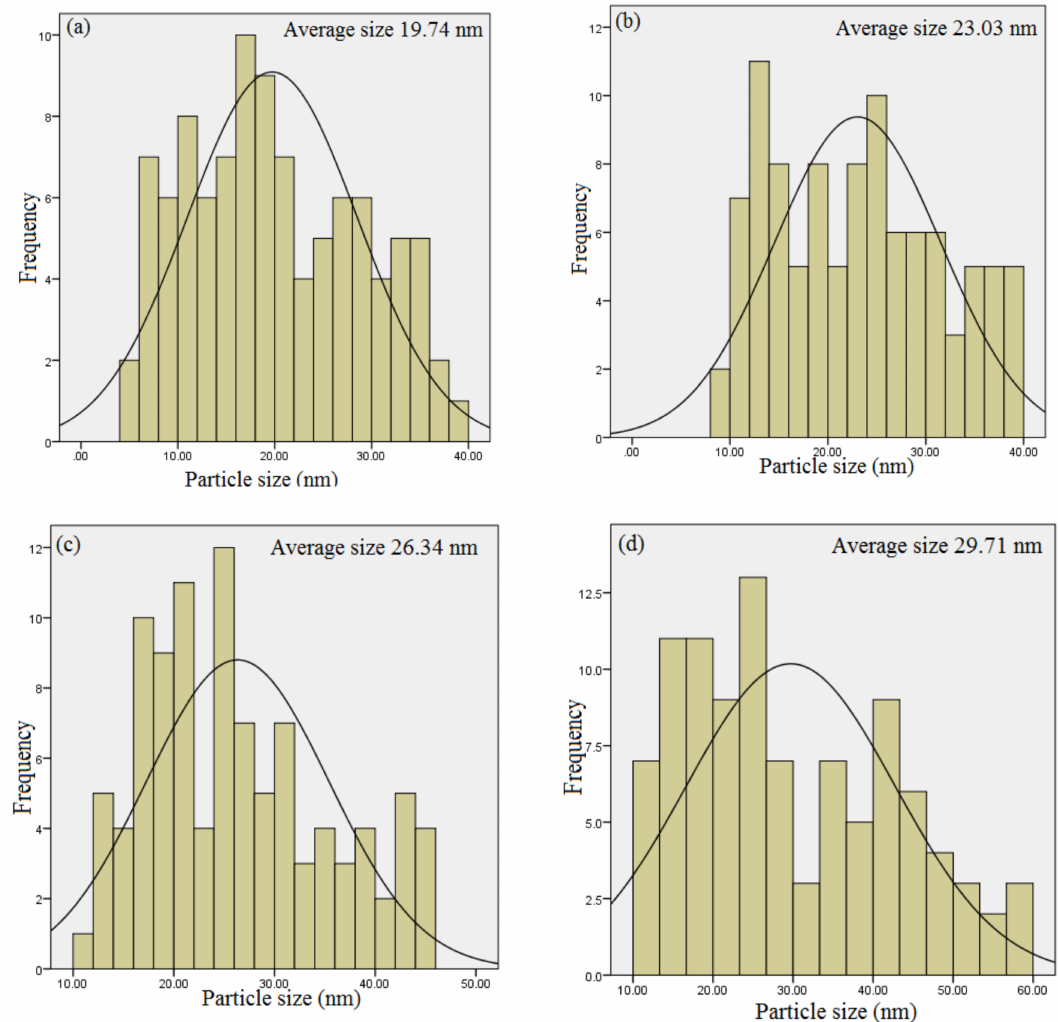
Figure 7. Particle size distribution of willemite NPs calcined at 900 ◦ C for several holding times ( a ) 1 h, ( b ) 2 h, ( c ) 3 h and ( d ) 4